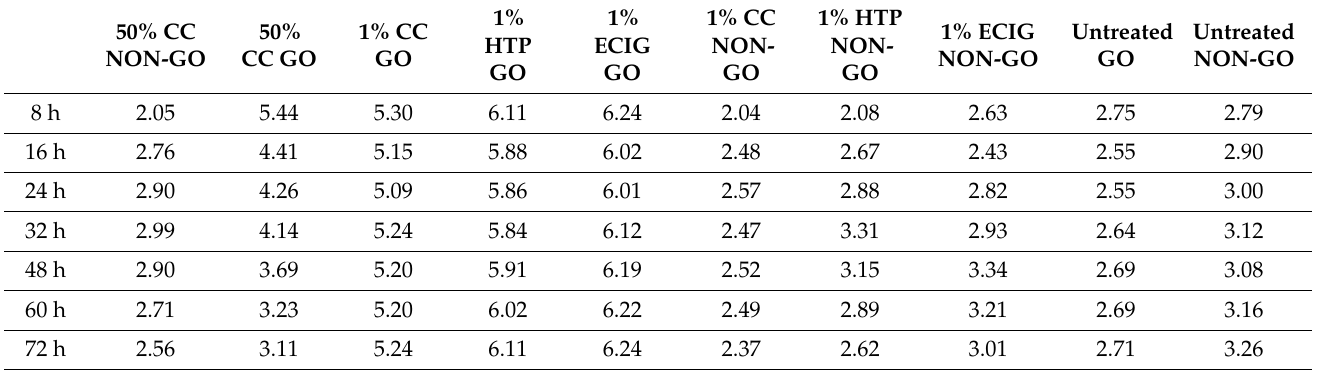
Table 1. CI values measured on all cell lines displayed in specific time points.